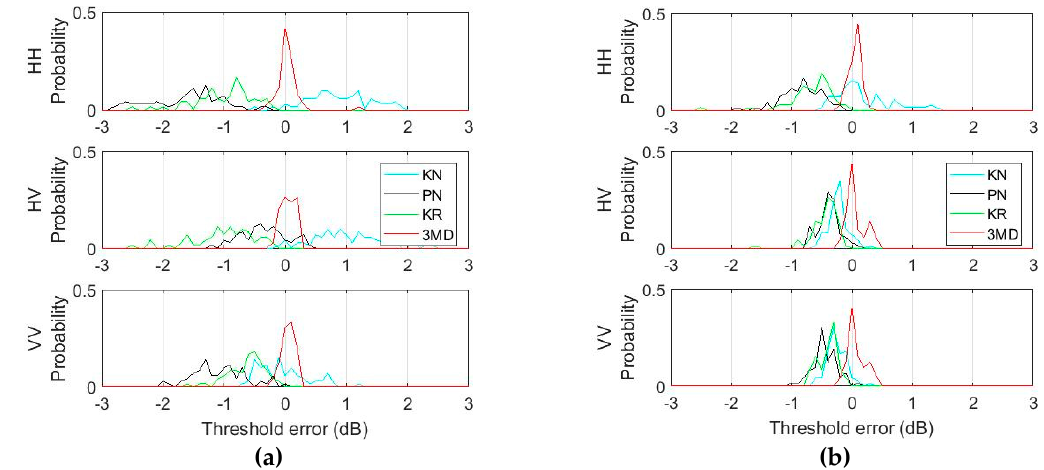
Figure 21. Threshold error histogram for SETHI, Run 8. Threshold error is measured at a CCDF of 10 − 4 . ( a ) X-band, ( b ) L-band.